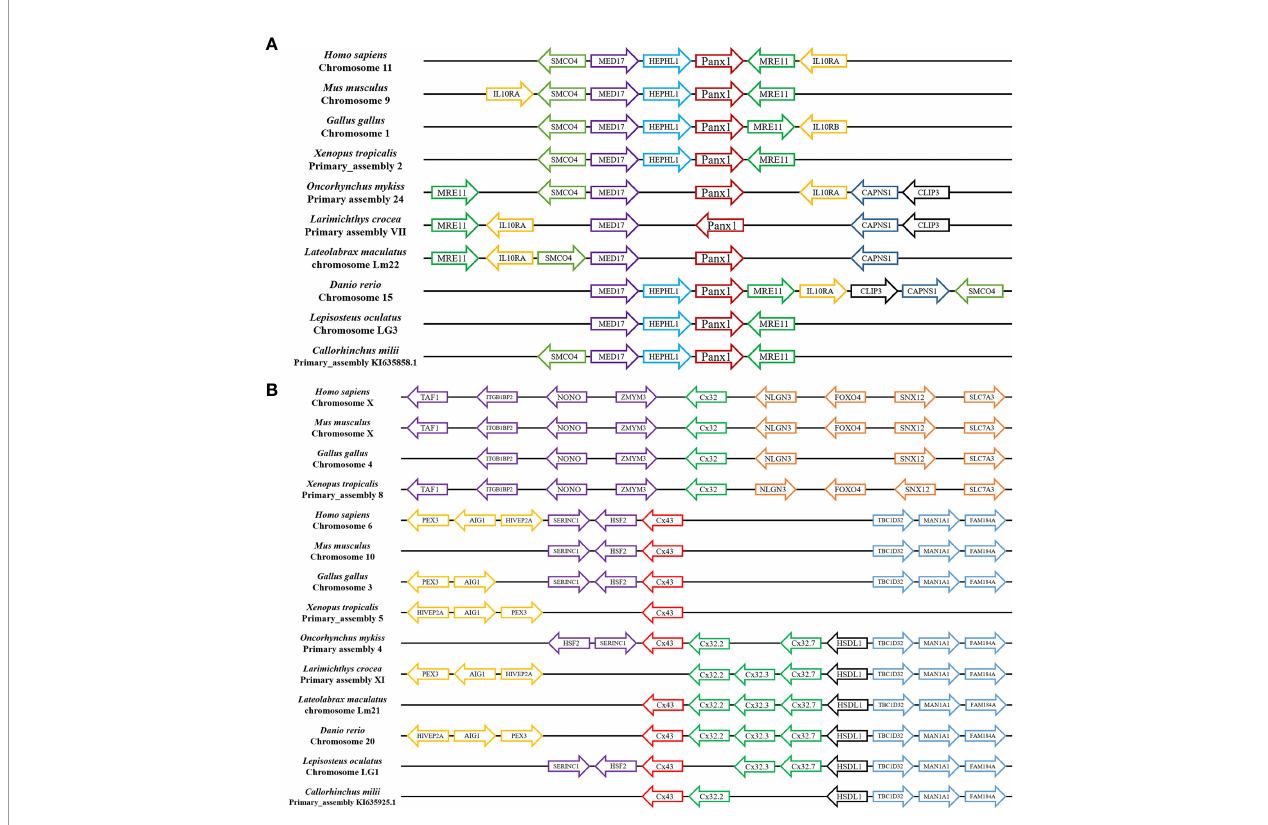
FIGURE 4 | Gene synteny of Panx1 (A) and Cx32 and Cx43 (B) . The Lm Panx1, Lm Cx32, and Lm Cx43 genome sequence data were obtained from the spotted sea bass genome database (https://www.ncbi.nlm.nih.gov/genome/43909). Synteny information for other vertebrates was retrieved from the Ensembl database (http://www.ensembl.org/index.html). Arrows indicate transcription